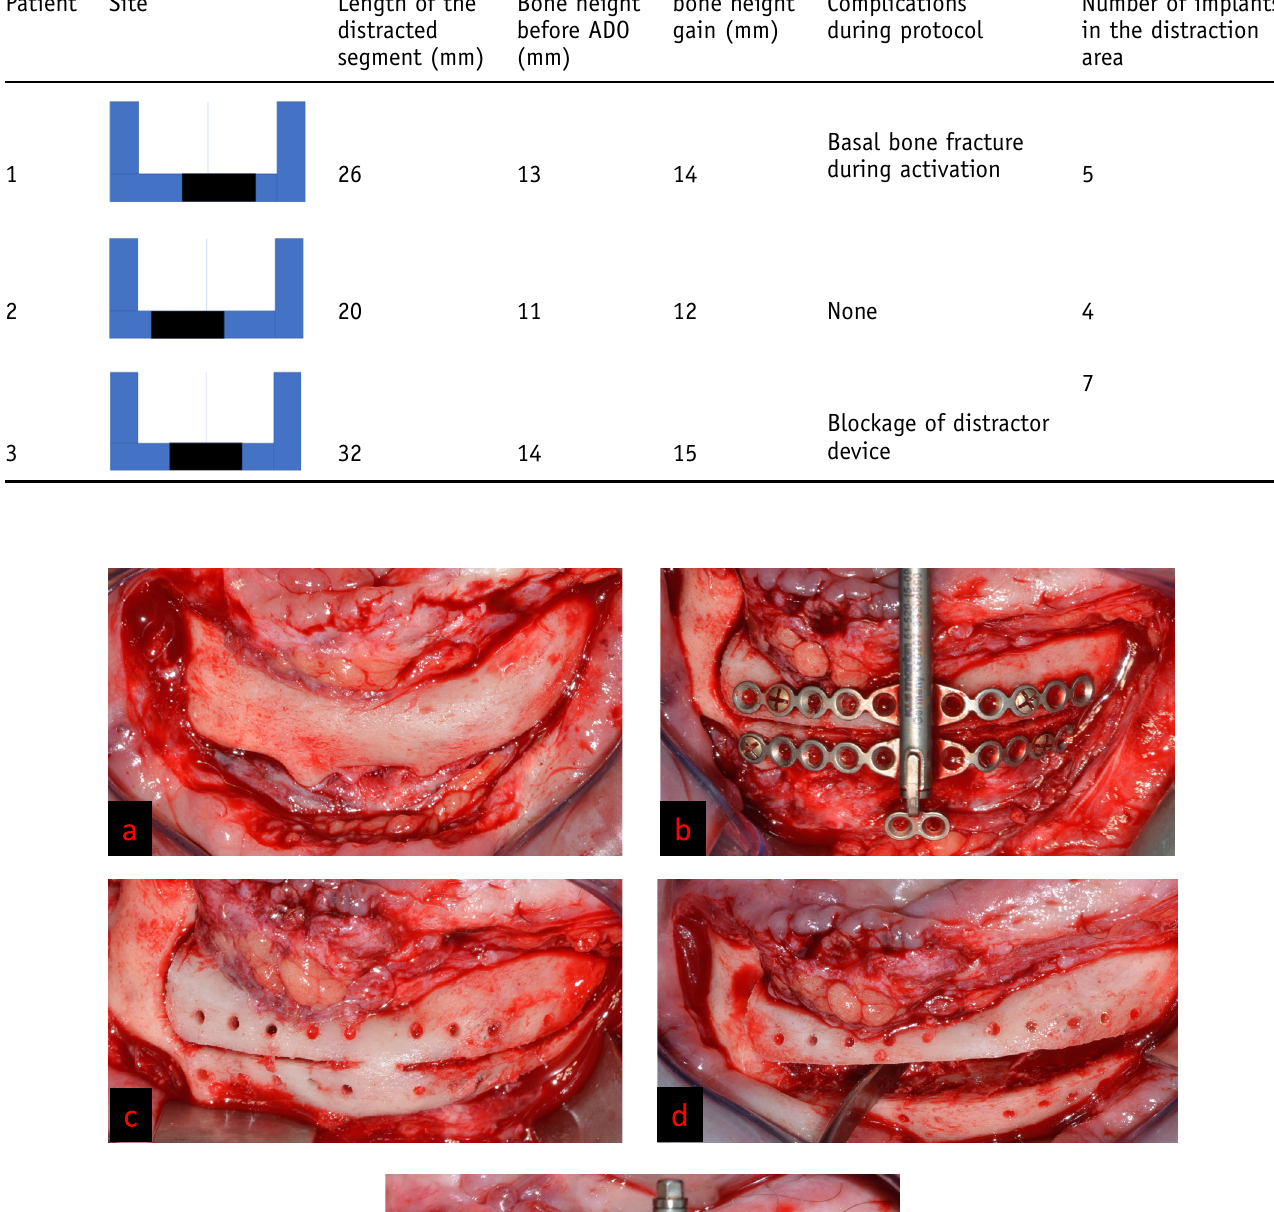
Table II. Data on resection, distraction, implants and prosthetic solution in three patients of the study. Patient